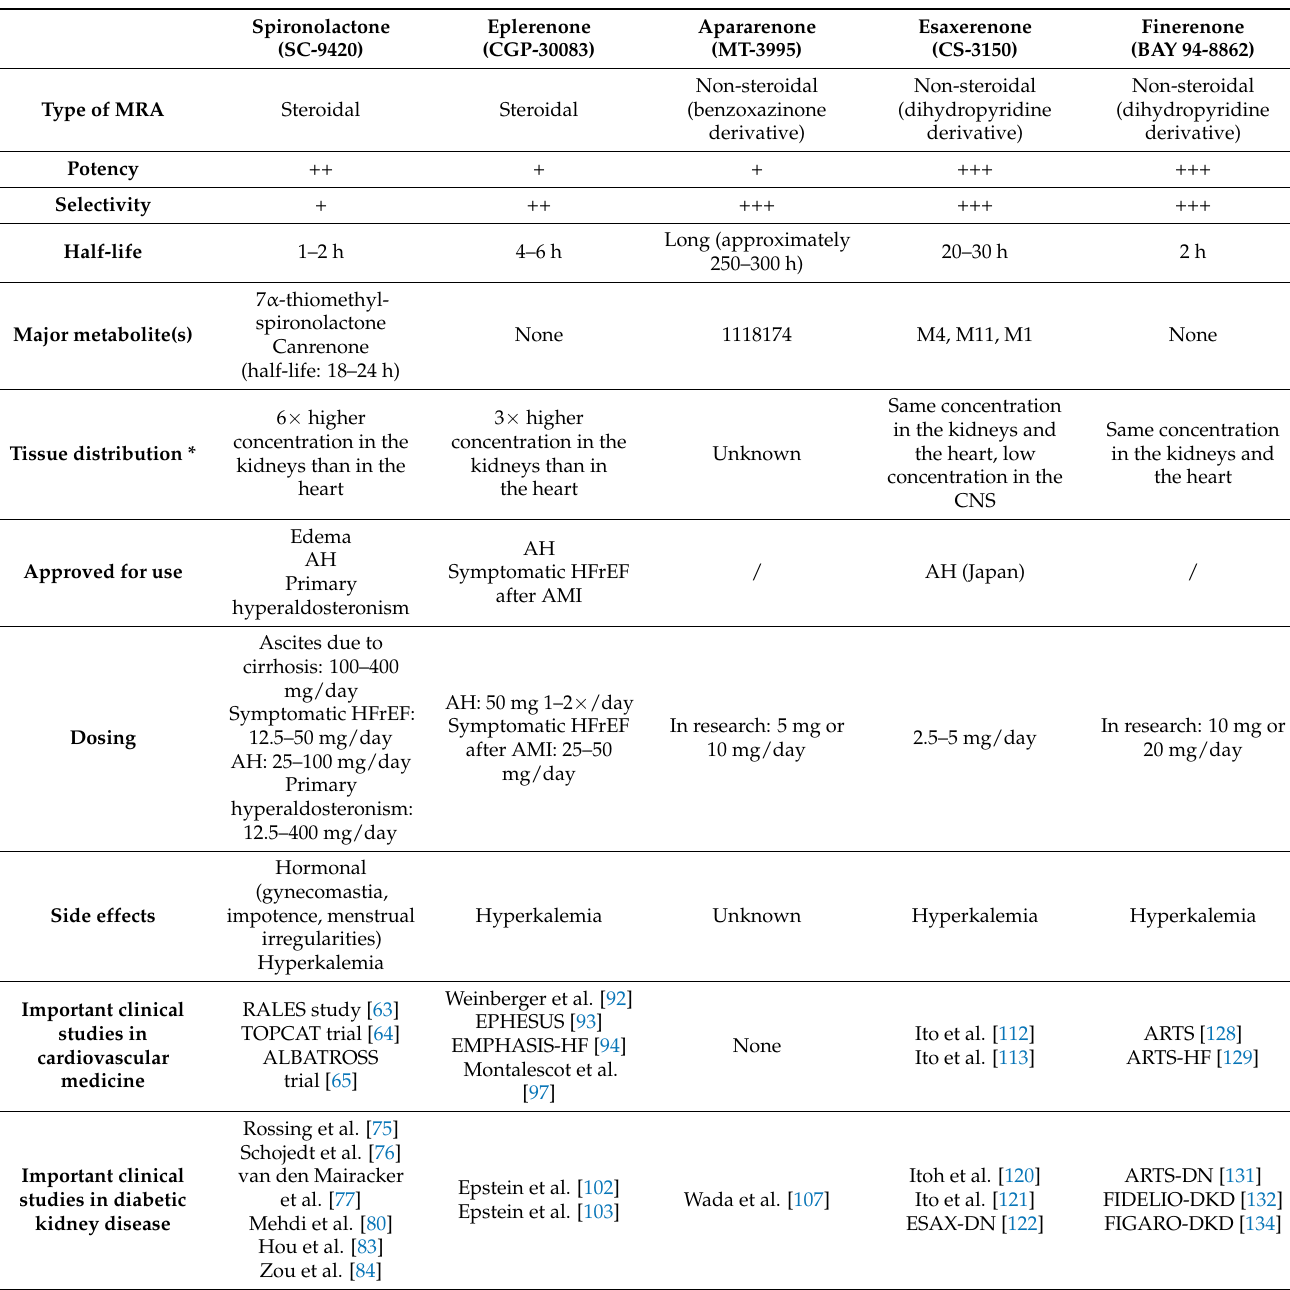
Table 1. Overview of mineralocorticoid receptor antagonists (MRA) used in everyday clinical practice and latest clinical